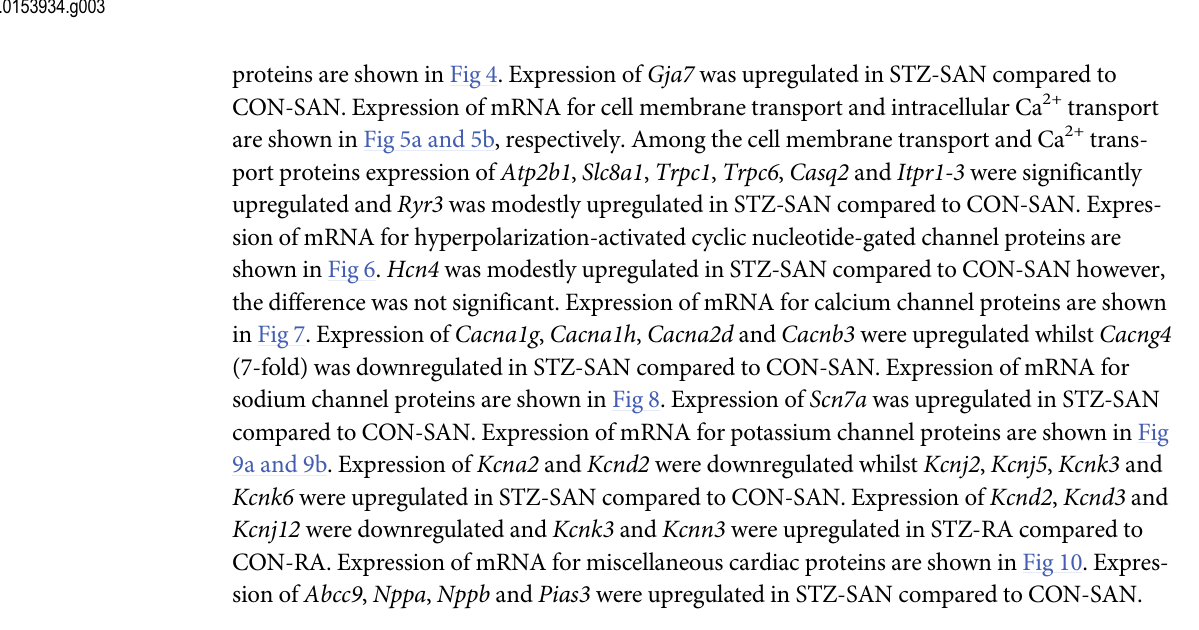
Fig 3. Expression of genes encoding various cardiac muscle proteins. Data are mean ± SEM, n = 4 – 10 samples from STZ and control rat each containing SANs from 2 hearts.